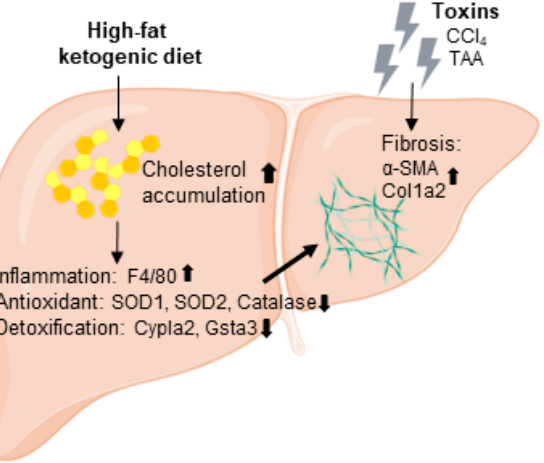
Figure 7. High-fat ketogenic diet feeding may trigger severe steatohepatitis and thereby promote CCl 4 - and TAA- induced liver fibrosis progression through enhanced liver inflammation and the loss of antioxidant and detoxification ability.